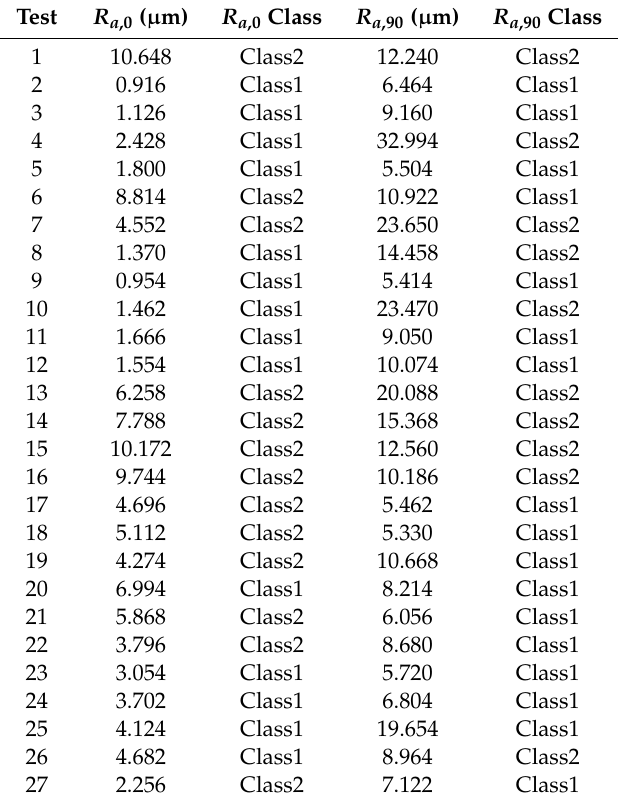
Table 4. Training dataset: results for surface roughness ( R a ,0 , R a ,90